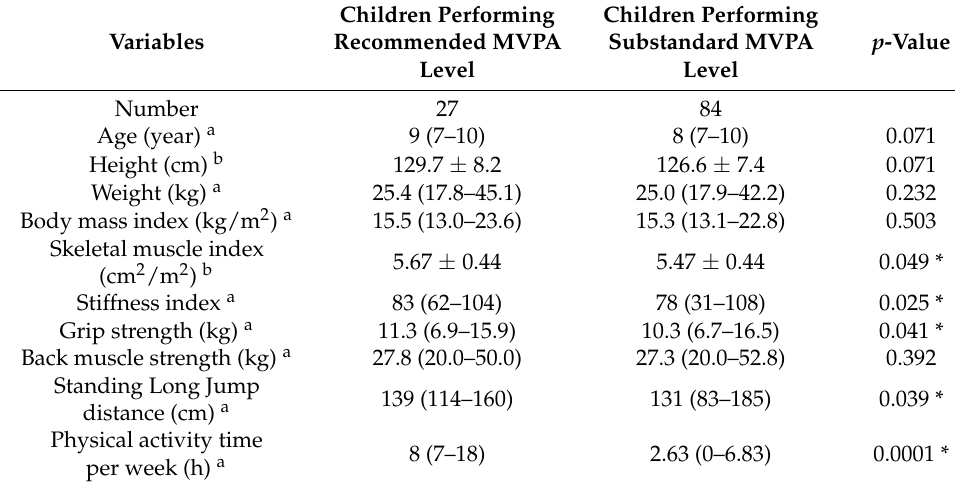
Table 1. Characteristics of participants.